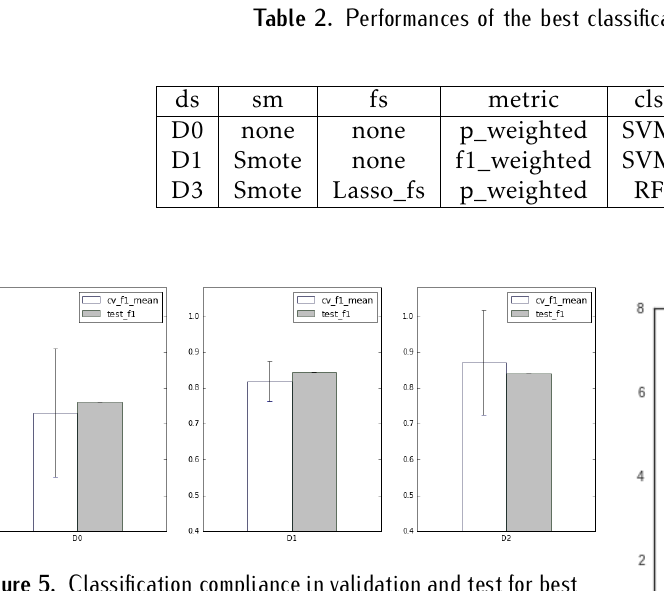
Figure 5. Classification compliance in validation and test for best predictive models. Table 3. Cluster centroids for each cluster.